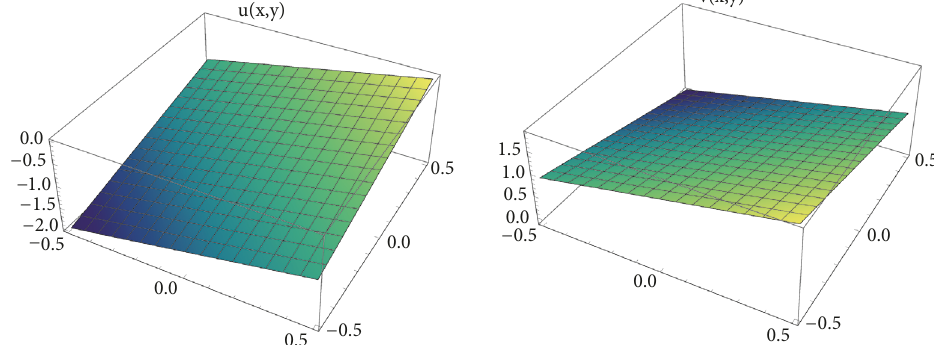
Figure 1: The approximate solution of Example 9 for 𝛼 = 0.99 and t = 0.1.